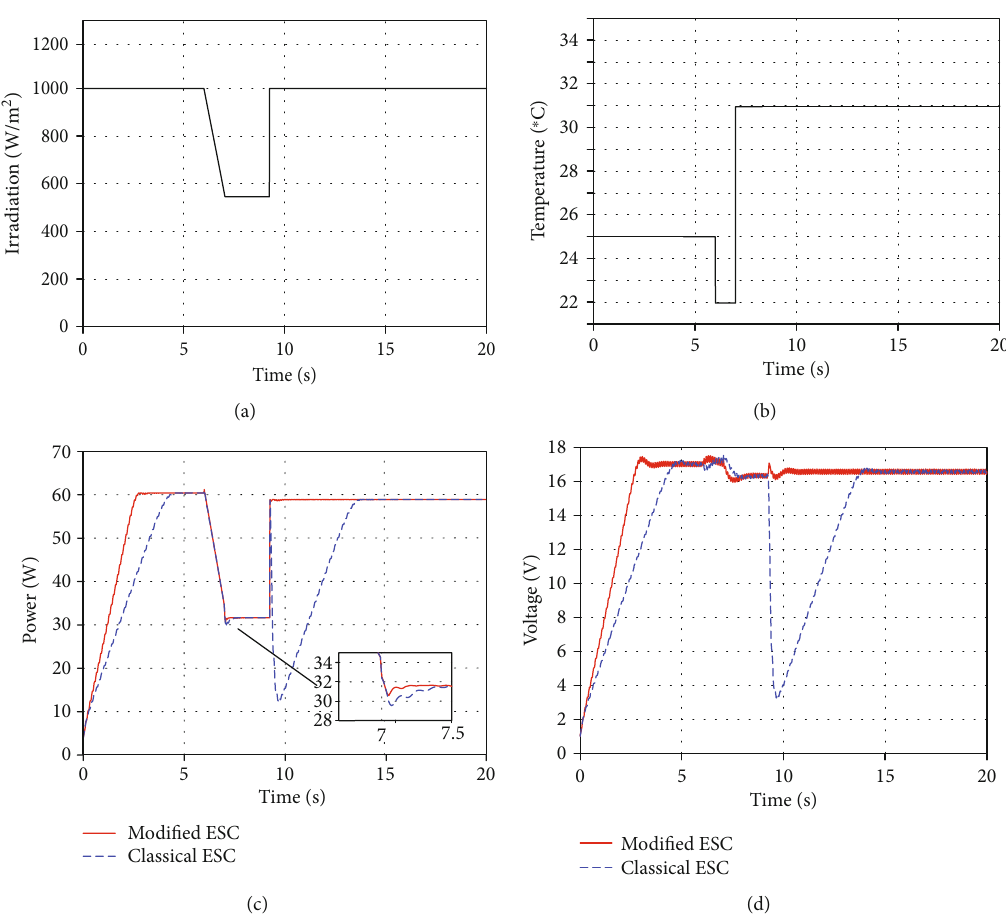
Figure 14: Comparative performances between modi fi ed extremum seeking control and classical extremum seeking control in the time